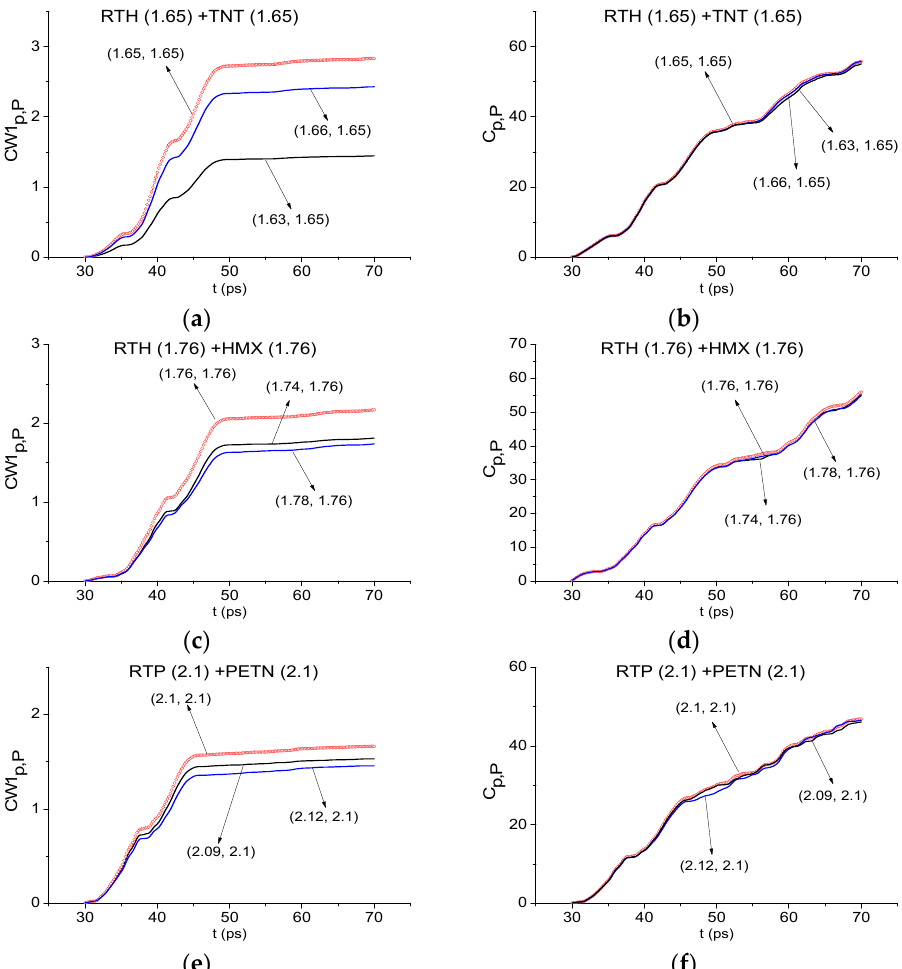
1 CW ( a,c,e ) and C ( b,d,f ) detecting the frequencies ν = Figure 15. Time-dependent ICCs CW 1 p , P ( a , c , e ) and C p , P ( b , d , f ) detecting the frequencies ν = 1.65 THz Figure 15. Time-dependent Figure 15. Time-dependent ICCs , p P , p P ( a,b ) and 1.76 THz ( c , d ) in the RTH first sub-pulse spectrum, and ν = 2.1 THz ( e , f ) in the RTP first 1.65 THz ( a,b ) and 1.76 THz ( c,d ) in the RTH first sub-pulse spectrum, and ν = 2.1 THz ( e,f ) in the sub-pulse spectrum. RTP first sub-pulse spectrum.